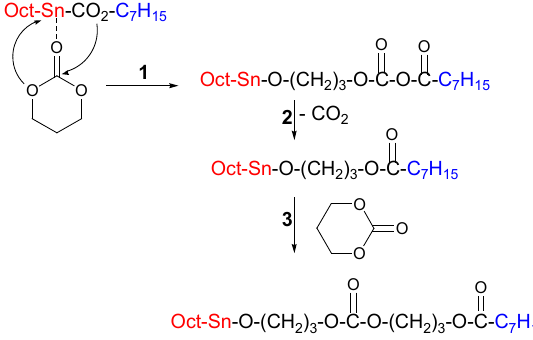
Figure 3. Coordination‐insertion mechanism [30].